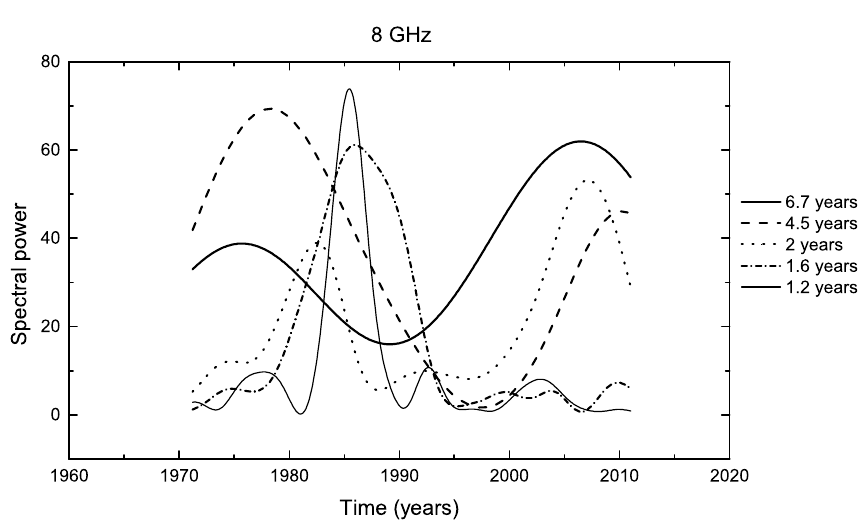
Fig. 4. The periods obtained by the wavelet analysis at 8.0 GHz.